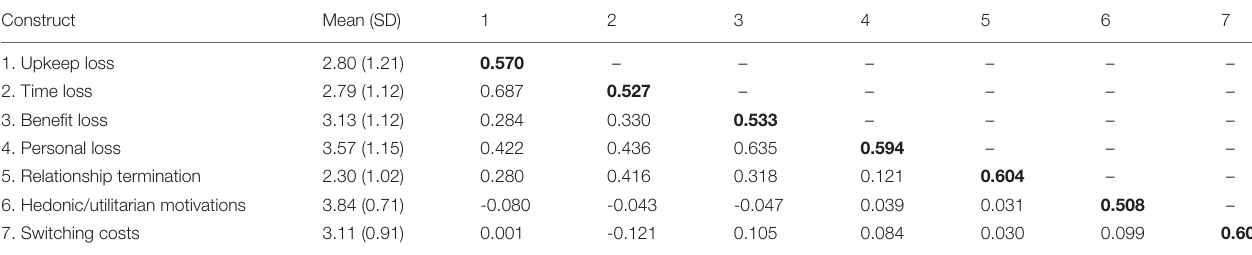
TABLE 3 | Measurement information and correlation matrix.